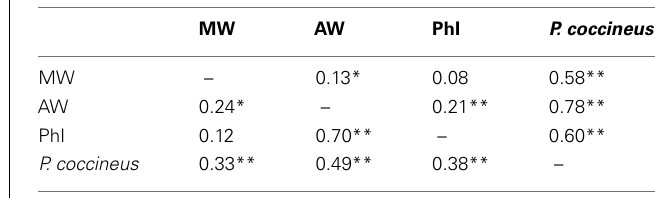
Table 4 | Genetic divergence ( F ST and R ST , below and above the diagonal, respectively) within the P. vulgaris populations and with P. coccineus .